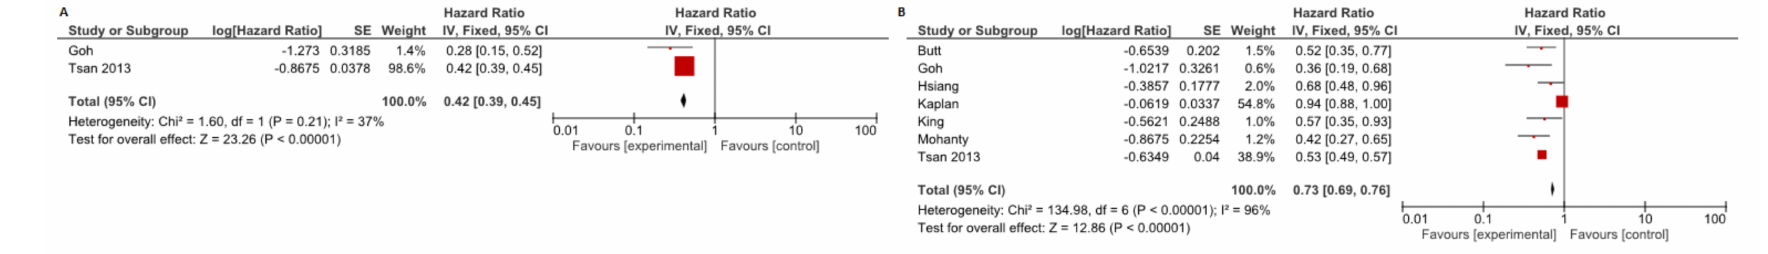
Figure 2. Odds ratio for HCC occurrence in the comparison between statin users and non-users: ( A ) crude odds ratio; and ( B ) adjusted odds ratio.